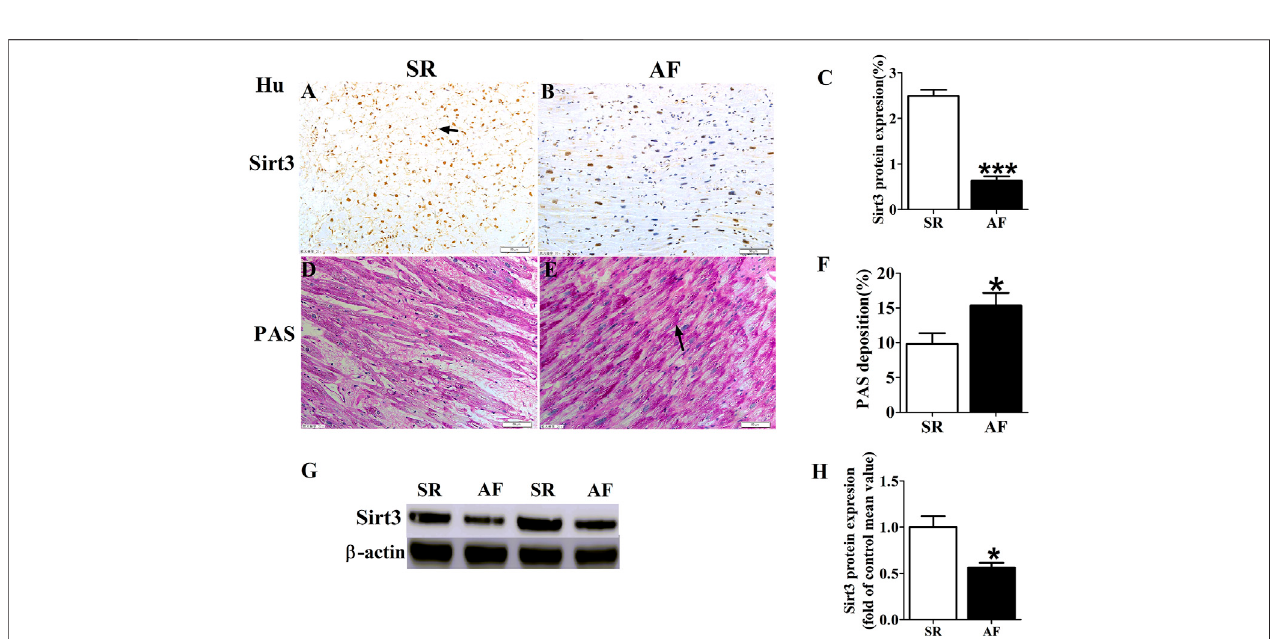
FIGURE 1 | Changes of Sirt3 and glycogen in AF patients. (A,B and C) Representative images and statistical results for protein expression of Sirt3 in the atria of patients. (D,E and F) Representative images and statistical results for the accumulation of glycogen in both groups of patients. (G and H) Representative bands and statisticalanalyzingforprotein expressionofSirt3inpatiets. Themagni fi cationis×20. * p < 0.05vs. SRgroup, Datafromthese proteinswerenormalized to β -actin, n=6 each group.